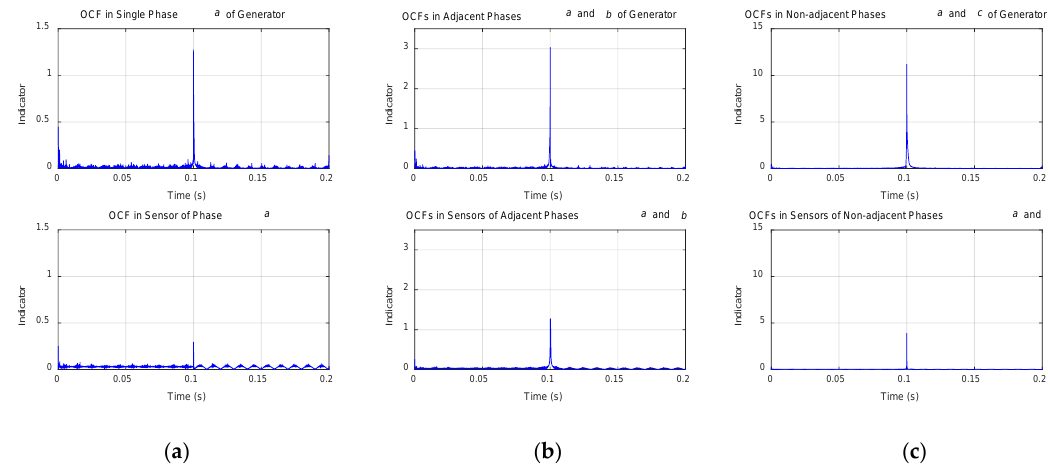
Figure 10. Indicate spike amplitudes distinguishing two different reasons leading to zero terminal phase current. ( a ) An OCF occurs in a generator’s single phase a , or its current sensor; ( b ) OCFs occur in generator’s two adjacent phases a and b , or their current sensors; ( c ) OCFs occur in generator’s two non-adjacent phases a and c , or their current sensors.